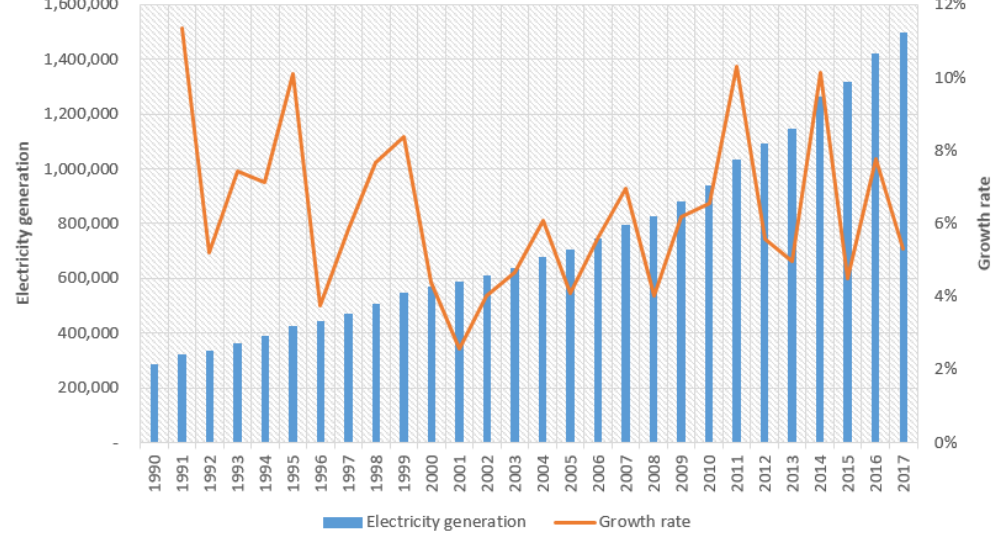
Figure 4 . The Indian power generation: 1990–2017, GWh, and the growth rates: 1990–2017.